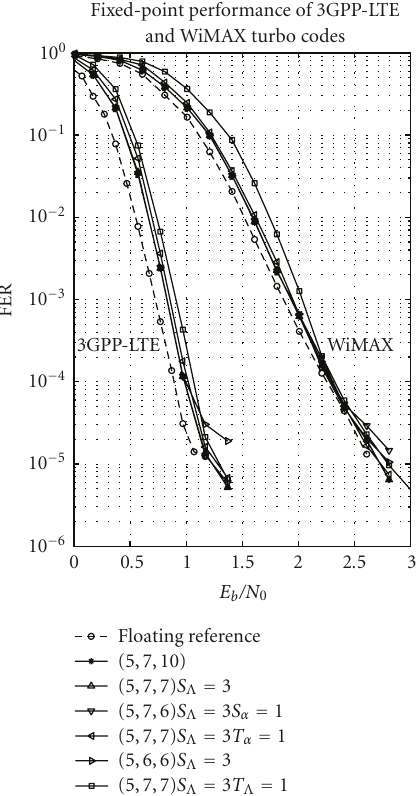
Figure 12: Dynamic range analysis for N